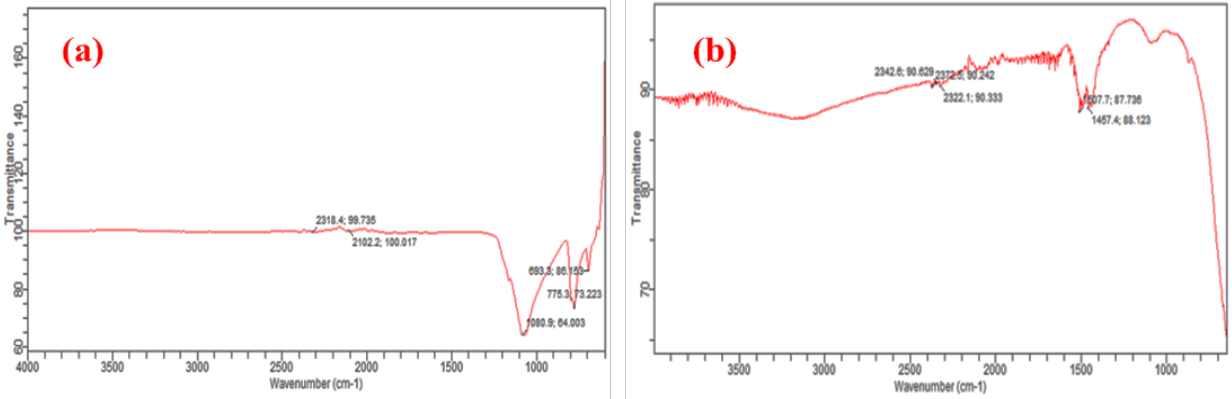
Figure 2. FTIR of ( a ) feldspar and ( b ) 20% Li-TiO 2 /feldspar.